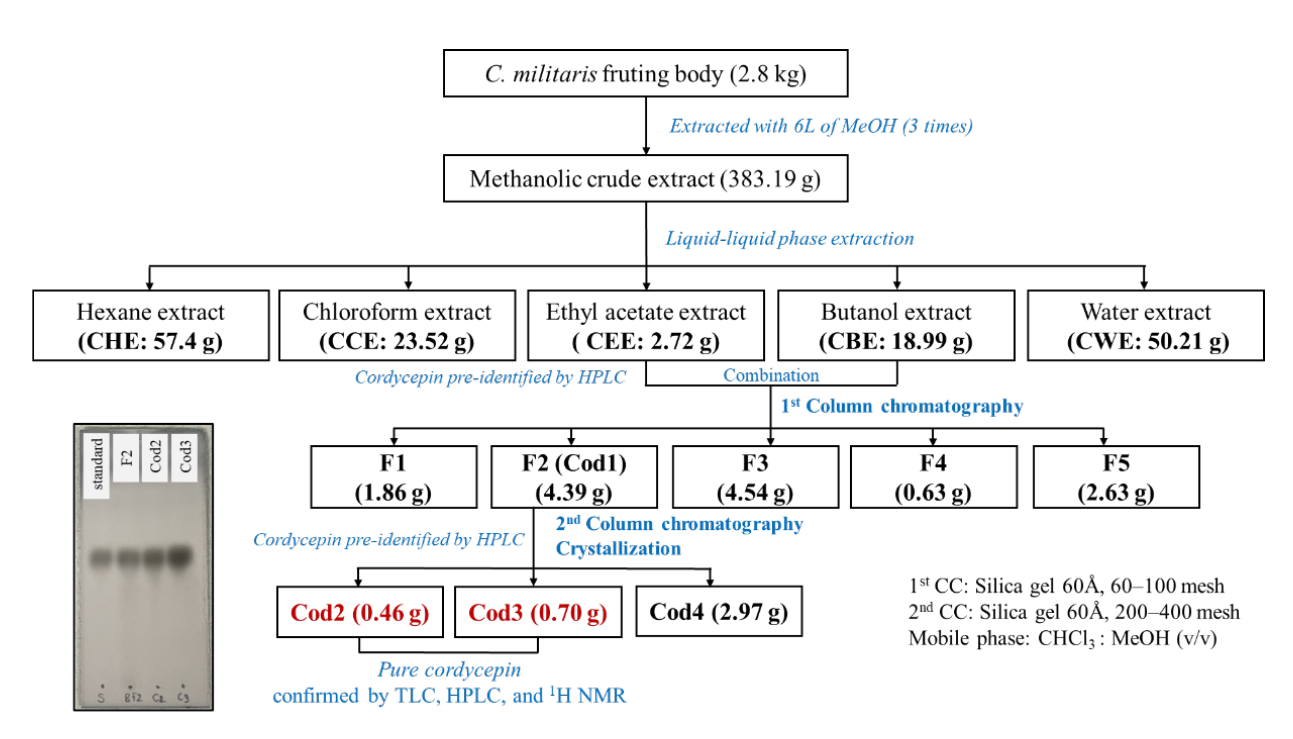
Figure 2. Extraction and isolation processes of cordycepin from Cordyceps militaris.